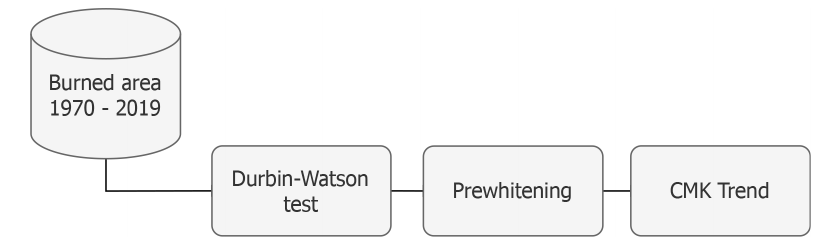
Figure 5. Flowchart depicting the processing steps for estimating the trend significance using the contextual Mann–Kendall method.